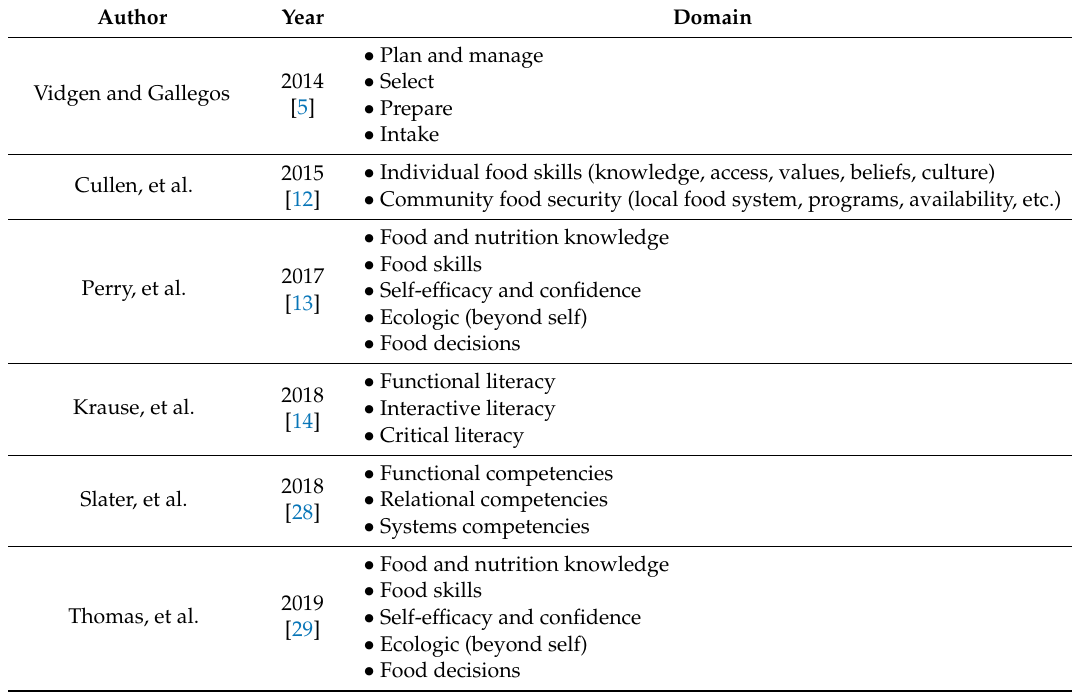
Table 2. Conceptual domains of food literacy from previous